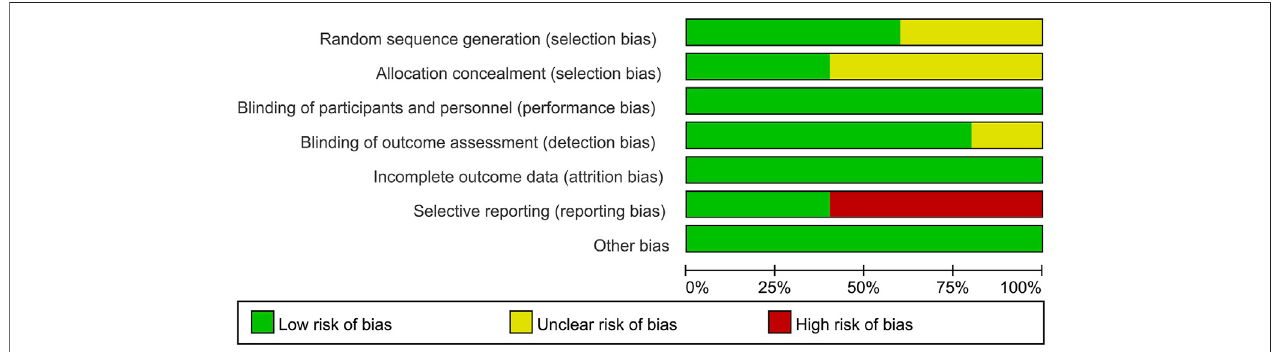
FIGURE 2 | Risk of bias graph: Data for each risk-of-bias item presented as percentages across all included studies.